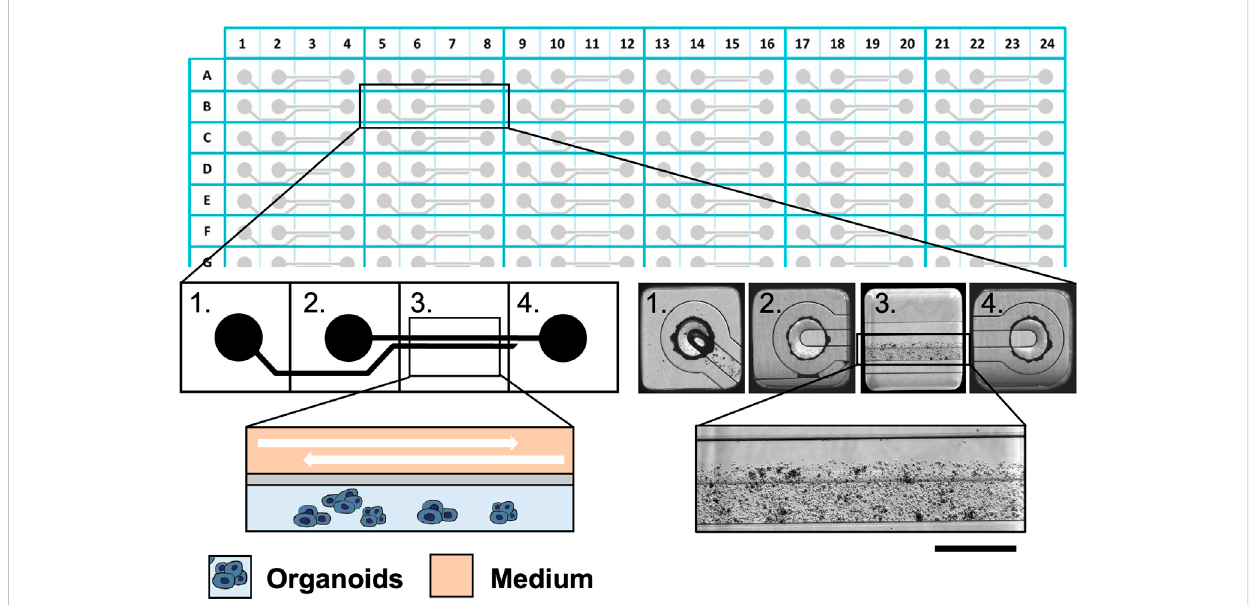
FIGURE 1 The Mimetas 2-lane OrganoPlate ® is a 384-well plate composed of 96 independent tissue culture chips. A graphical representation of the chip is provided on the left, while bright fi eld images are shown on the right. Each chip is composed of 4 units: 1) the gel inlet, 2) the medium inlet 3) the observation window, and4) themedium outlet.Intheobservation window, itispossibleto distinguishtwo micro fl uidic channels: theupperone inwhich the medium fl ows and the lower one which are the organoids in the ECM. Scalebar is 250 μ m. ”